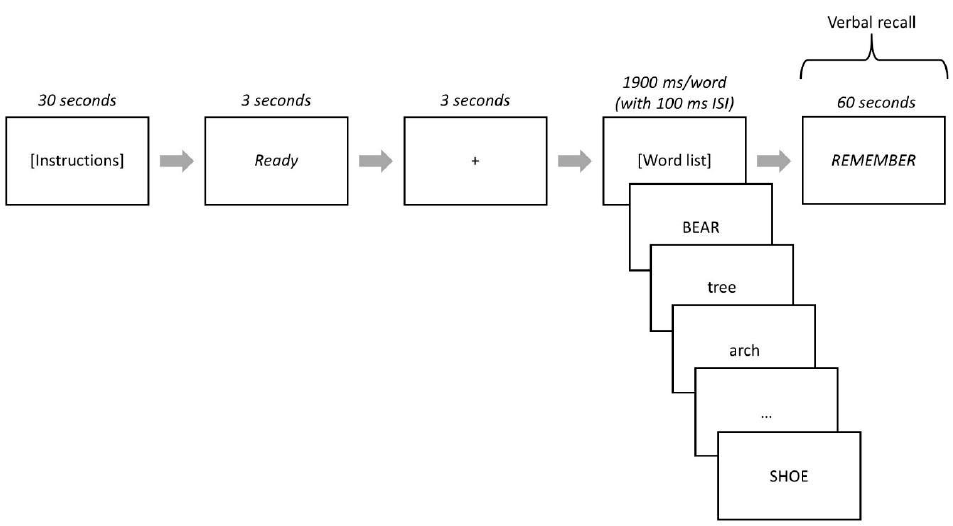
Figure 1. Strategic Processing Task Schematic. High- and low-value words were represented by lowercase or uppercase words depending on the task version. When the word “REMEMBER” was presented, participants verbally recalled words from the list and their responses were recorded on paper and scored. This process was repeated for all five lists.